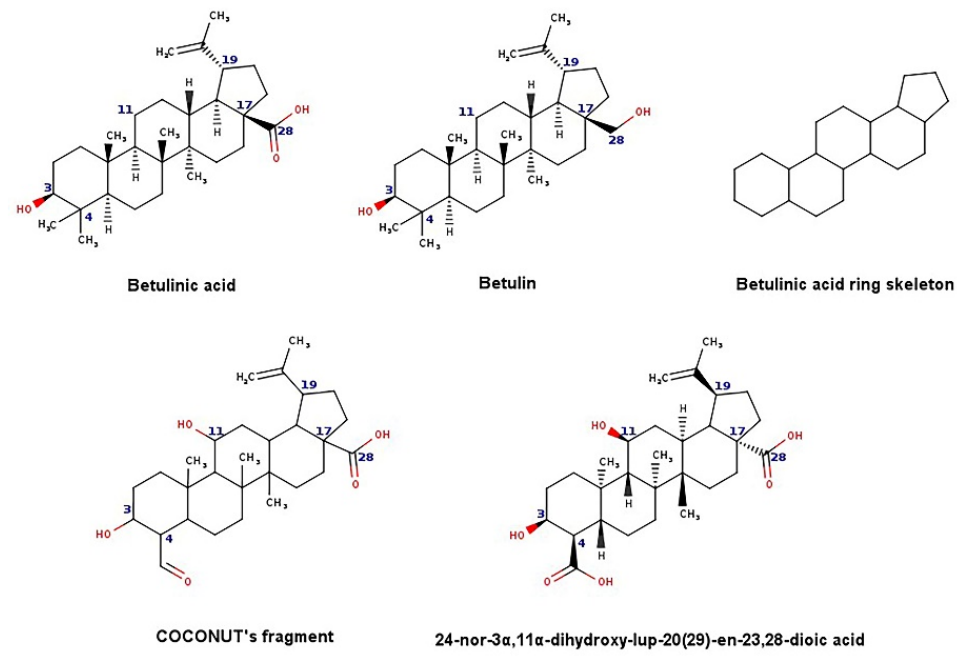
Figure 4. Chemical structures of betulinic acid, betulin, cyclic system skeleton derived from betulinic acid, COCONUT’s fragment with betulinic acid ring skeleton derived from the 24-nor-3 α ,11 α -dihydroxy-lup-20(29)-en-23,28-dioic acid.